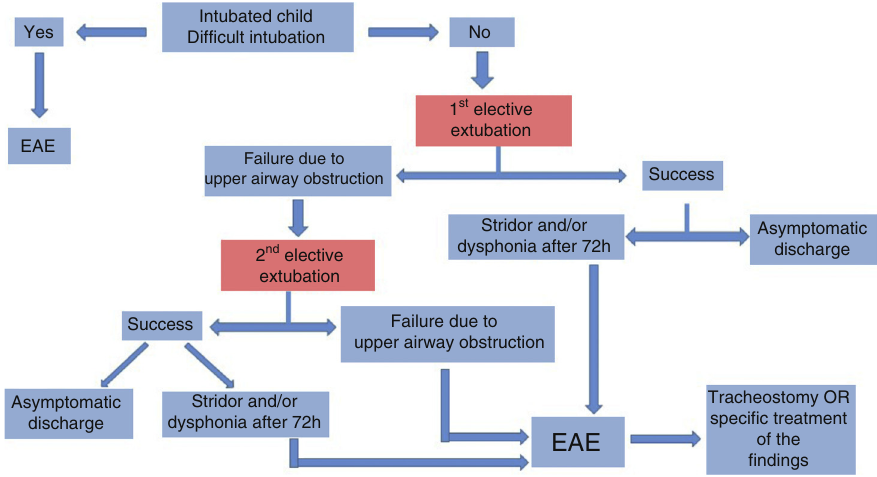
Flowchart indicating preoperative endoscopic airway evaluation (EAE) in the intubated